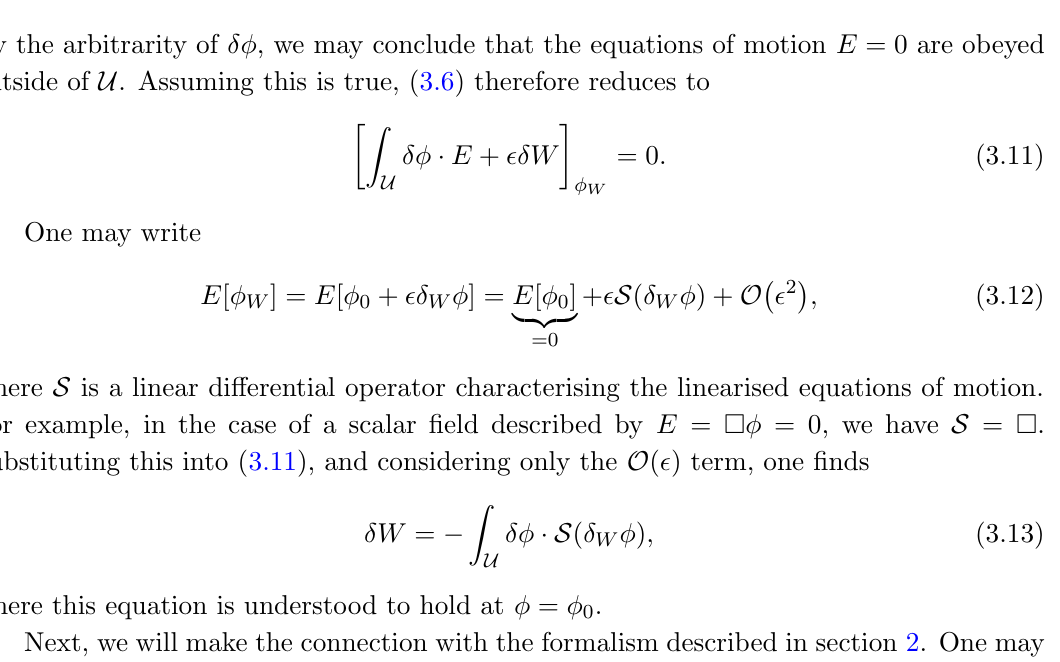
Figure 1 . (cid:6) (cid:26) U (cid:26) M . The action is deformed by a source term at the codimension one surface